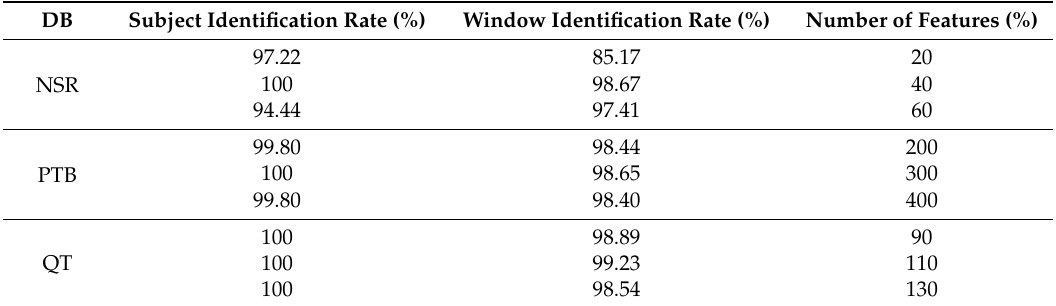
Table 5. Comparison of results according to the number of features with linear discriminant analysis (LDA).